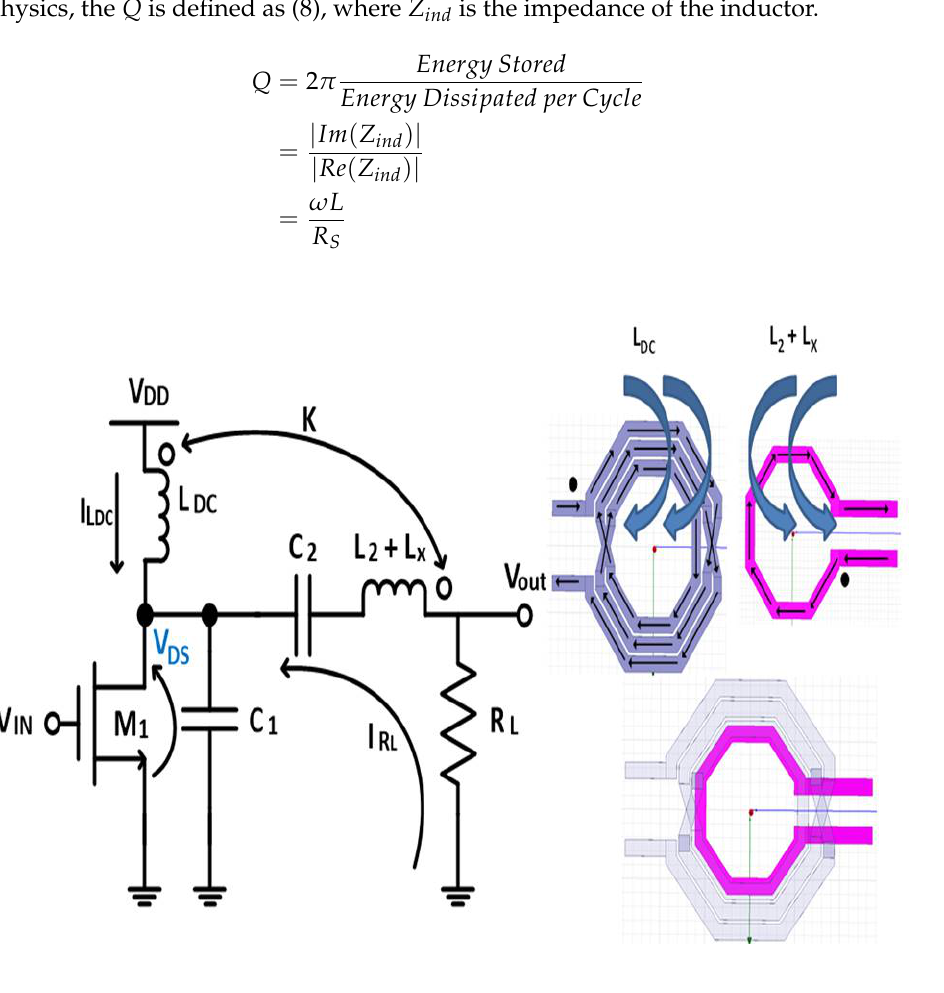
Figure 2. Transformer-Based Class-E PA: magnetic coupling and determining correct dot